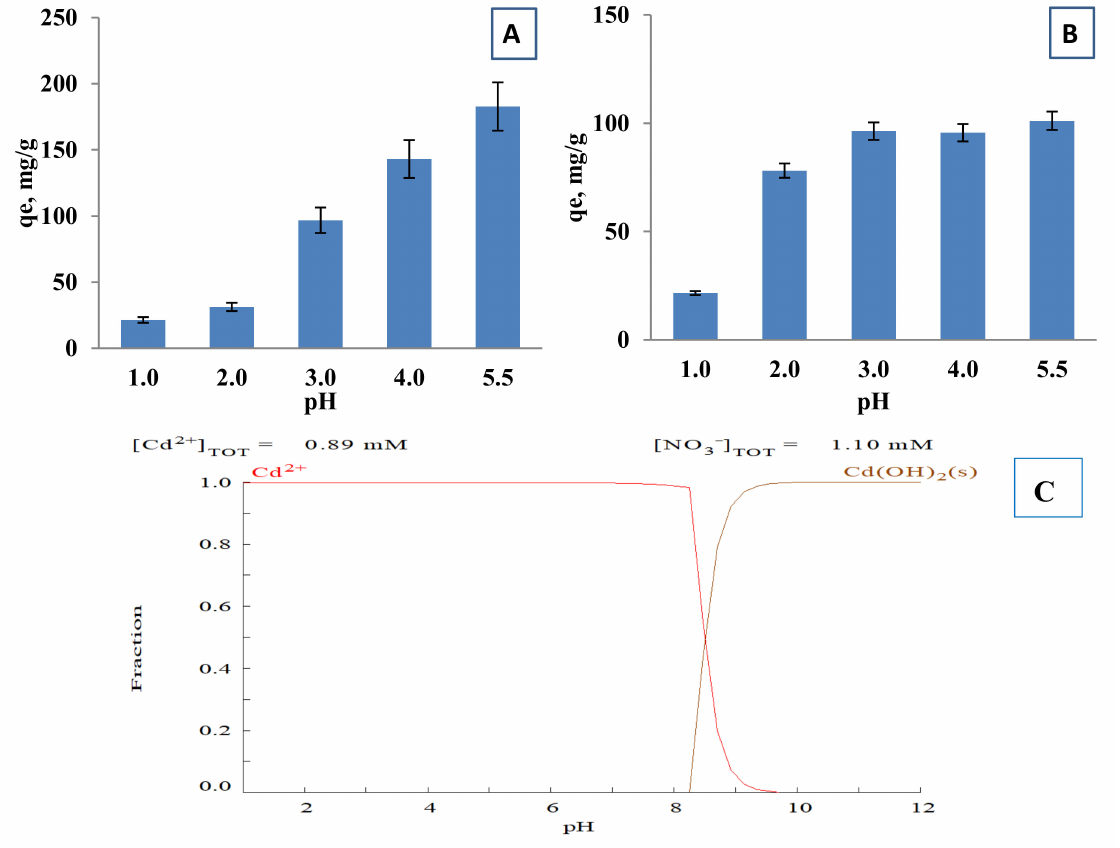
Figure 5. Equilibrium loading of Cd 2 + ions by ( A ) p(MAAc)-DMAAm-AA and ( B ) p(AMPS)- DMAAm-AA cryogels and ( C ) the speciation of cadmium ions at di ff erent pH